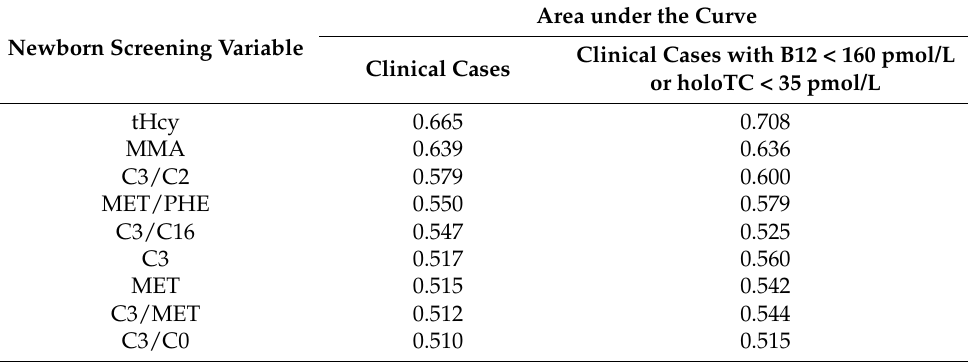
Figure 2. ROC curves of newborn screening parameters’ diagnostic accuracy of being a case with B12 deficiency, cases and matched controls, n = 716. MET = methionine, PHE = phenylalanine, C0 = carnitine, C2 = acetylcarnitine, C3 = propionylcarnitine, C16 = palmitoylcarnitine, tHcy = total homocysteine, MMA = methylmalonic acid. Table 6. ROC areas under the curve, diagnostic accuracy of newborn screening parameters for being a case with B12 deficiency; clinical cases (n = 70), clinical cases with B12 < 160 or holotranscobalamin < 35 pmol/L (n = 30) and matched controls (n =